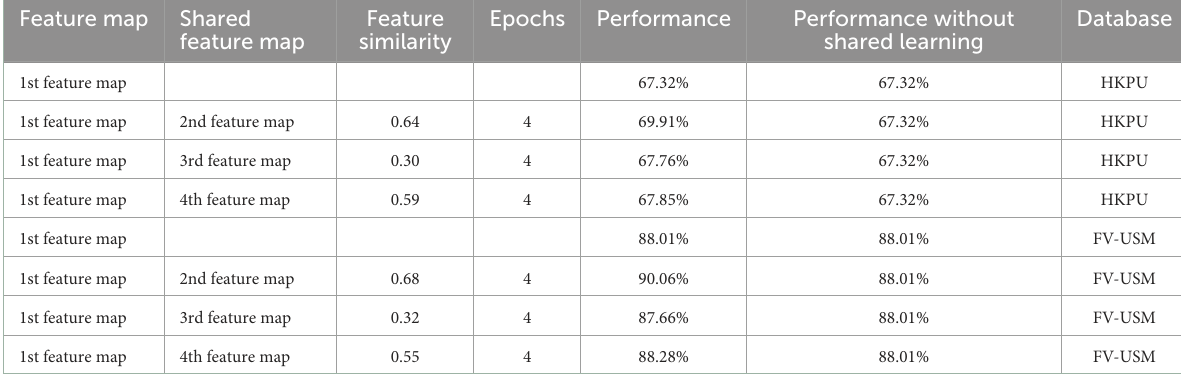
TABLE 5 Performance comparisons of shared learning.